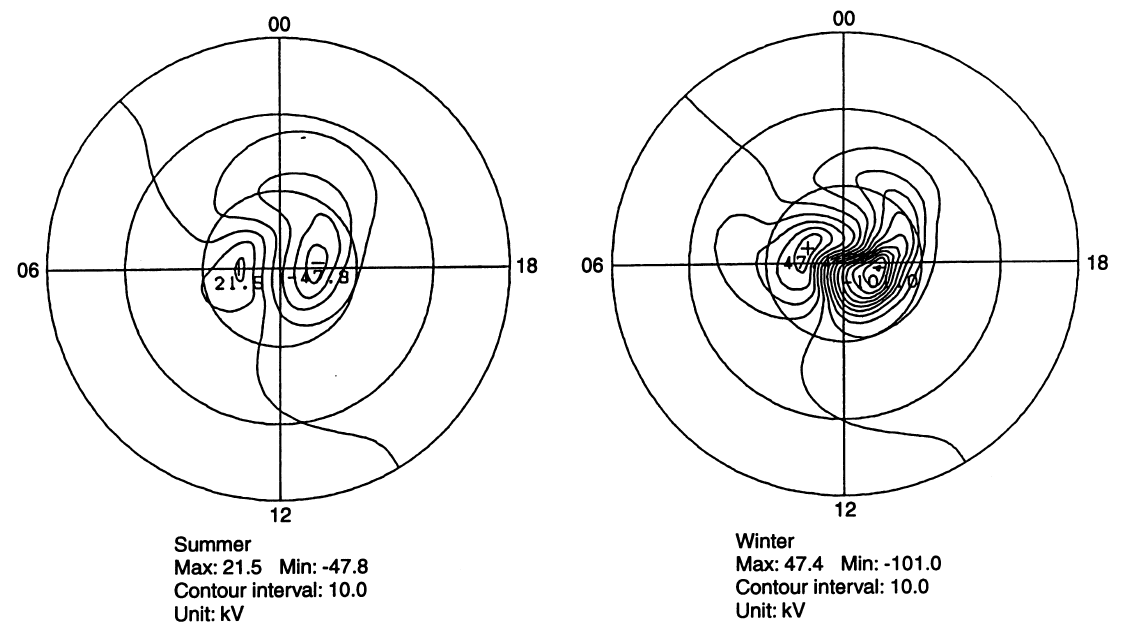
Fig. 10. Same as Fig. 9 for the